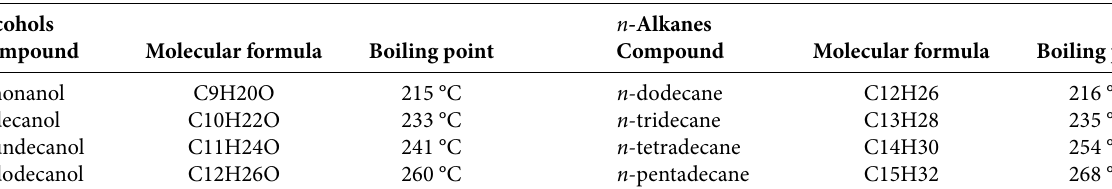
Table 5. The boiling point of alcohols and n -alkanes